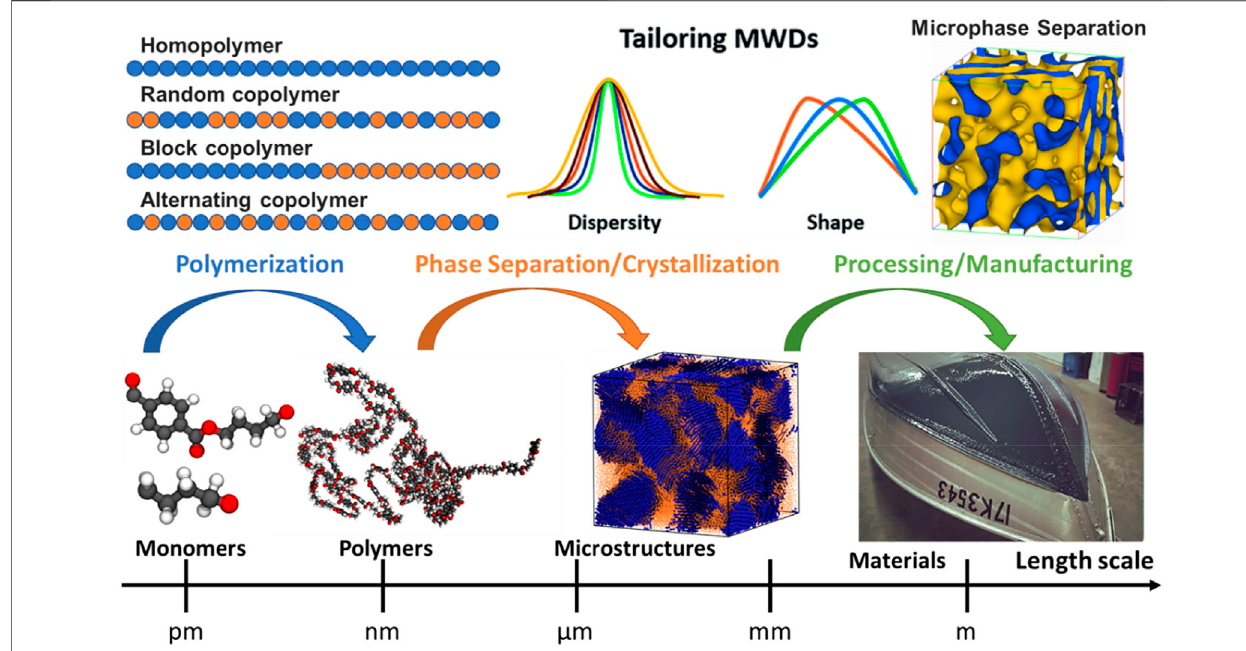
FIGURE 1 | A hierarchical design principle for polymeric materials, considering their monomer, chain, microstructure, processing, and manufacturing. The architecture of polymer chains, along with their molecular compositions (monomers), determines the microstructure of polymers, such as phase separation and crystallization. Monomer is a repeat unit comprising a polymer ’ s chemical structure. If there is only a single type of monomer, the polymer is known as a homopolymer, while a polymer containing two or more types of monomers is called a copolymer. In copolymers, monomers can arrange in a variety of manners such as random, block,gradient, or alternating. Acontrolled monomer sequence vigorously in fl uences the polymerchainproperties, ultimately leading tothe desired phase separation or crystallization of microstructure.